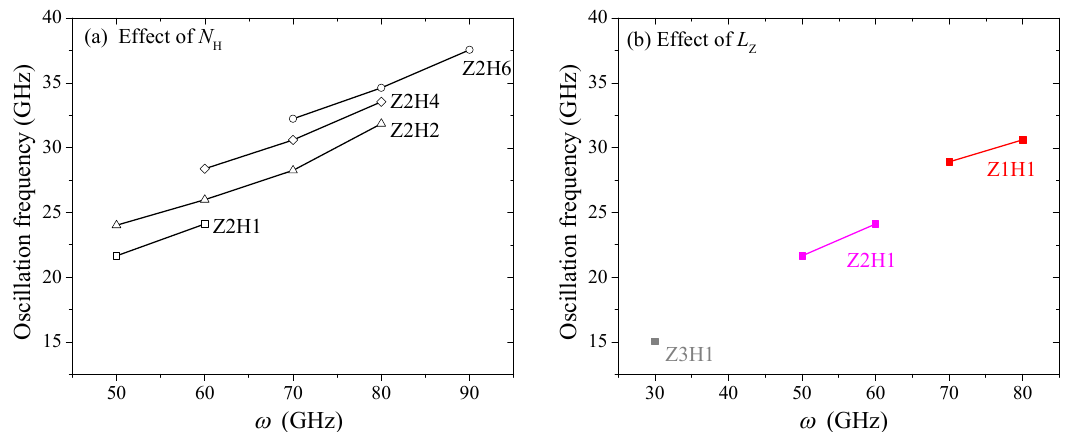
Figure 3. Oscillation frequencies of the d curves with amplitudes higher than 0.5 nm during 9–10 ns obtained using a fast Fourier transmission (FFT) method: ( a ) effect of the hydrogenation scheme ( N H ) on the HDP and ( b ) effect of the axial length of the HDP ( L z).